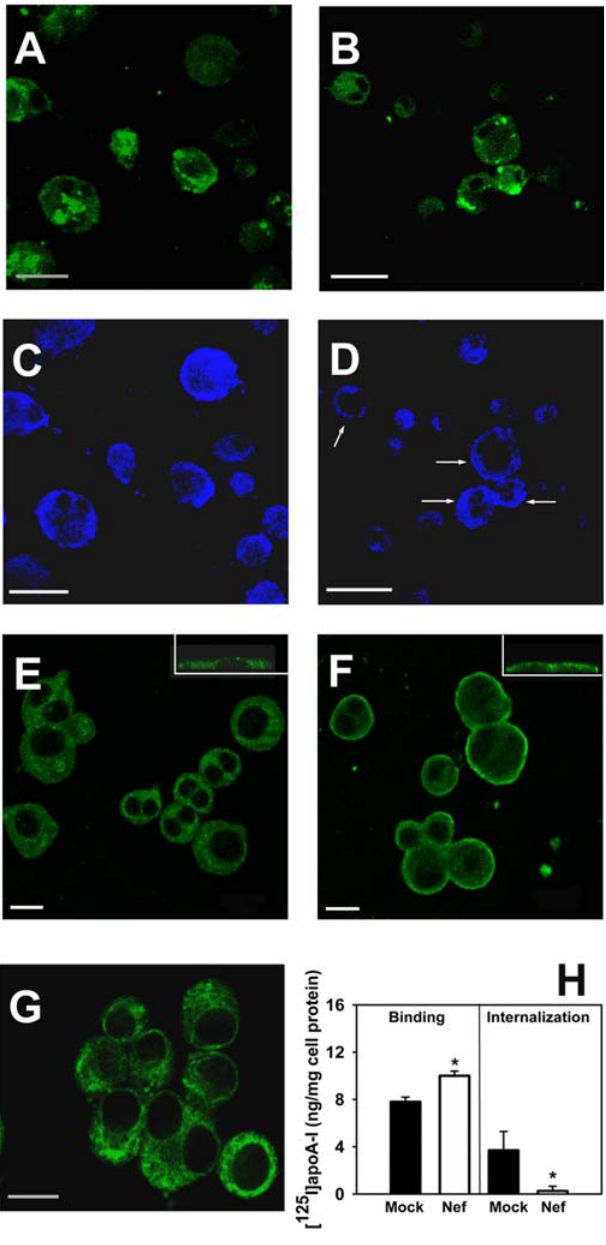
Figure 4. The Effect of Nef on ABCA1 Localization (A–D) On day 5 after infection with VSV-G-pseudotyped Nef-expressing (B and D) or D Nef (A and C) HIV-1 SF2, cells were co-stained with anti-p24 mouse monoclonal and anti-ABCA1 rabbit polyclonal antibodies, followed by FITC-conjugated anti-mouse (A and B) and Cy5-conjugated anti-rabbit IgG (C and D). Arrows point to cells with re-localized ABCA1. The scale bars represent 20 l m. (E–G) Distribution of ABCA1 revealed by staining with monoclonal anti- ABCA1 antibody and FITC-conjugated anti-mouse IgG in RAW 264.7 cells transfected with empty vector (E), WT Nef derived from SF2 HIV-1 ( Nef.wt, panel [F]), or SF2 Nef carrying a G2A mutation ( Nef.G2A , [G]). Insets in (E and F) show cross-section of the image reconstituted from serial sectioning. Scale bars represent 20 l m. (H) [ 125 -I]apoA-I binding (left panel) and internalization (right panel) in RAW 264.7 macrophages transfected with HIV-1 SF2-derived Nef. An asterisk (*) indicates p , 0.01. DOI: 10.1371/journal.pbio.0040365.g004